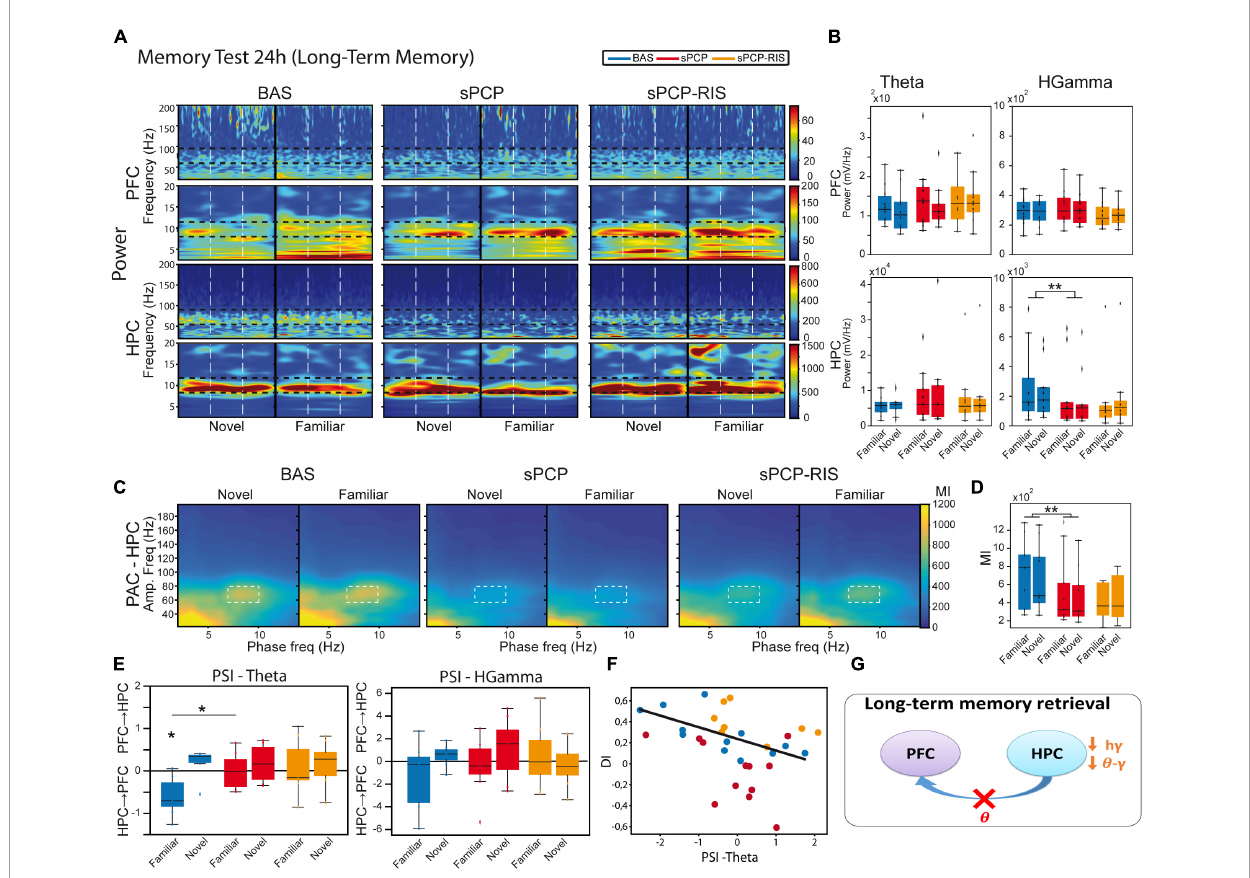
FIGURE5 Neural substrates of long-term memory and effects of sPCP and risperidone. (A) Power spectra in the mPFC and the dHPC during the 24h memory test and effects of sPCP and risperidone. Vertical dashed lines mark the first second upon initiation of the visits. (B) Power in the mPFC and the dHPC was similar during visits to familiar and novel objects. sPCP reduced high gamma power in the dHPC non-specifically ( F ( 1 , 12 ) = 15.33, p = 0.006; mixed ANOVA with object (familiar vs. novel) and treatment (baseline vs. sPCP) as factors; differences with SAL controls, F ( 1 , 20 ) = 5.28, p = 0.021; mixed ANOVA with object (familiar vs. novel) and treatment (SAL vs. sPCP) as factors). As above, risperidone partially rescued hippocampal gamma power. (C,D) Intrinsic hippocampal theta-gamma coupling (7–10 Hz with 60–80 Hz) was similar during visits to familiar and novel objects. sPCP disrupted theta-gamma coordination that was partially rescued by risperidone ([l-PAC] F ( 1 , 12 ) = 15.96, p < 0.003; differences with sPCP-SAL controls: F ( 1 , 22 ) = 6.31, p = 0.021; mixed ANOVAs as above). Similar results were obtained for inter-regional theta-gamma coupling ([ir-PAC] F ( 1 , 12 ) = 33.19, p < 0.0005; differences with sPCP-SAL controls: F ( 1 , 22 ) = 5.97, p = 0.02; data not shown). (E) In healthy mice, dHPC → mPFC theta signals were detected during the visits to the familiar objects (PSI vs. shuffle, p = 0.031; paired t -student). sPCP disrupted this flow of information (baseline vs. sPCP, p = 0.024; PSI vs. shuffle, p = 0.94) that was not rescued by risperidone (PSI vs shuffle, p = 0.64). (F) dHPC → mPFC PSI at theta frequencies during the visits to familiar objects correlated strongly with discrimination indices during baseline (R = –0.72, p = 0.01), but not after sPCP (R = –0.42, p = 0.17) or risperidone (R = –0.47, p = 0.24). (G) Proposed neural mechanism for LTM and effects of sPCP and risperidone. In red, changes produced by sPCP, in orange sPCP-induced deviations ameliorated by